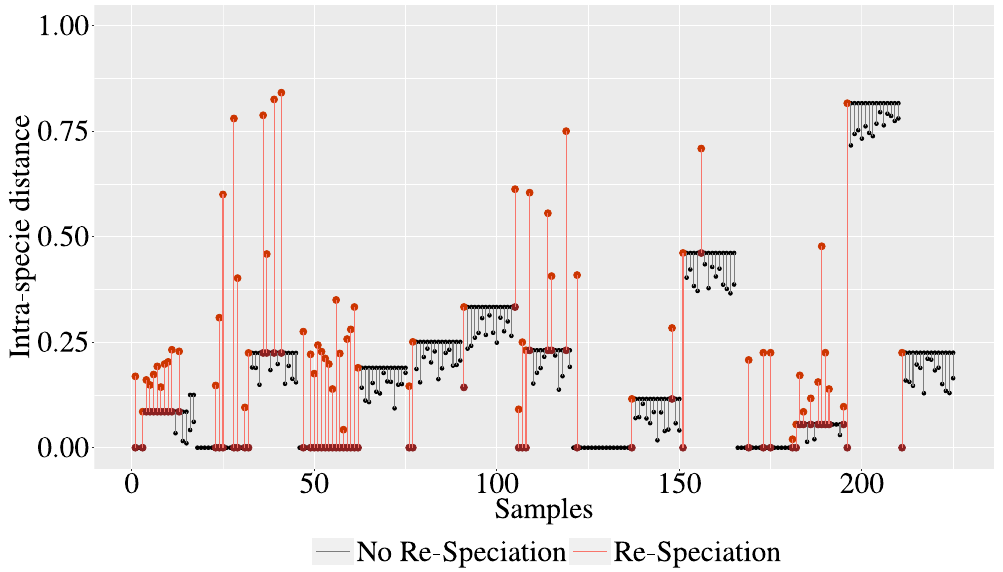
Figure 10. Analysis of the re-speciation process using the intra-species